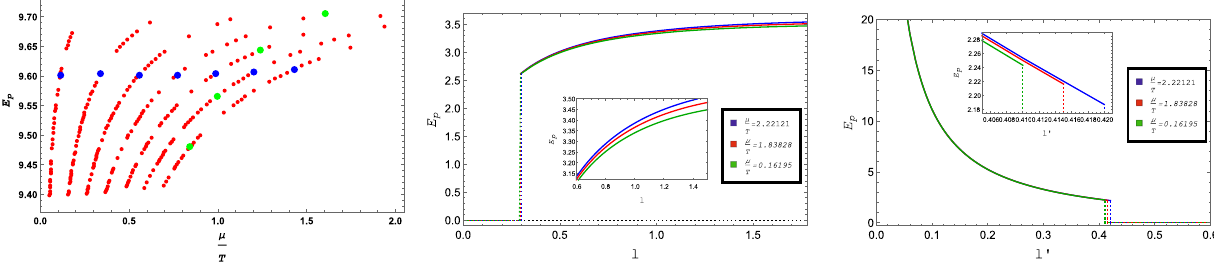
Fig. 9 Left: the EoP with respect to μ 1-dimensional field theory. The blue and green points show T = 0 . 459 and μ = 0 . 508, respectively. Middle: the EoP with respect to l for l (cid:3) = 0 . 3 in 2 + 1-dimensional field theory. Right: The EoP with respect